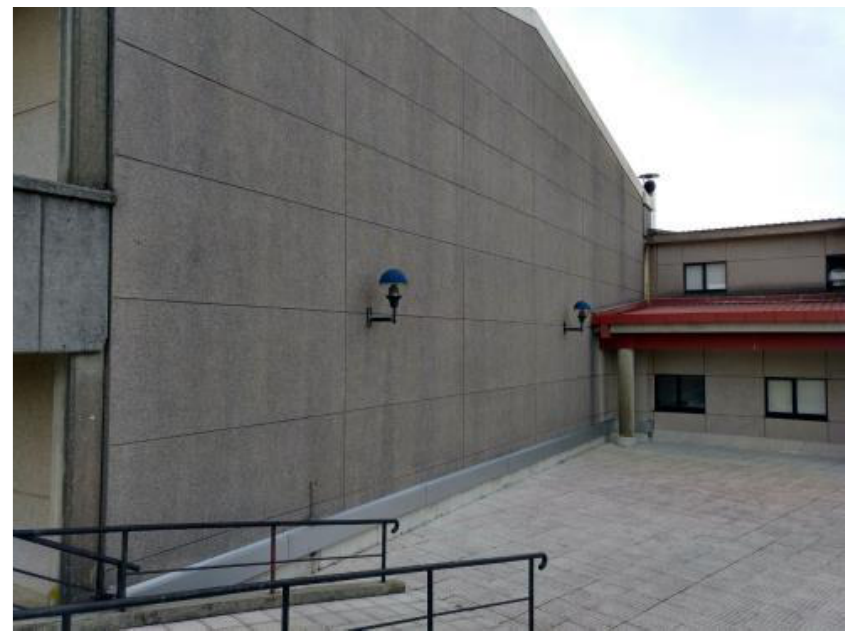
Figure 8. Building facade with windows.